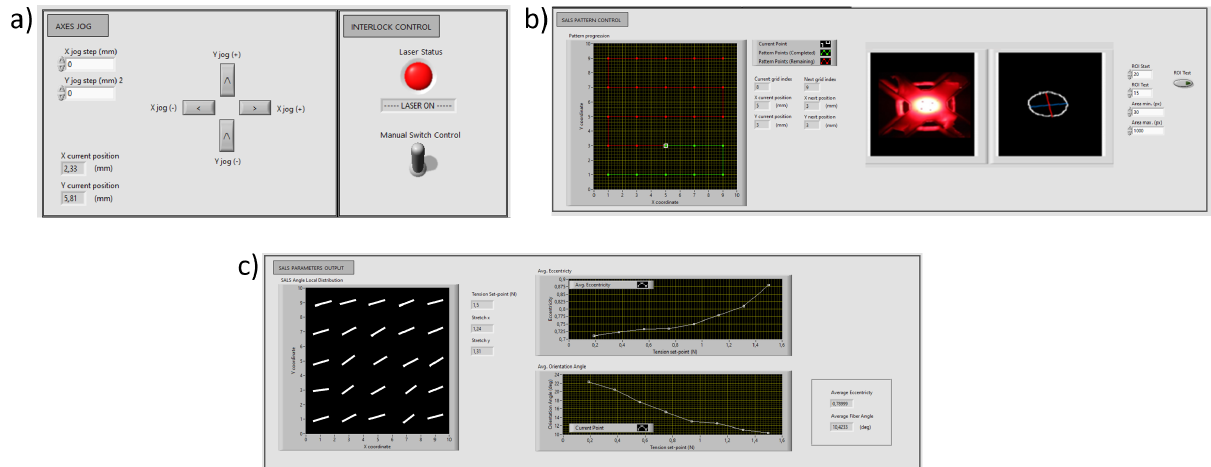
Figure 8. GUI for the LA side including axes jog ( a ), SALS irradiation pattern control and monitoring ( b ) and SALS output visualization ( c ).